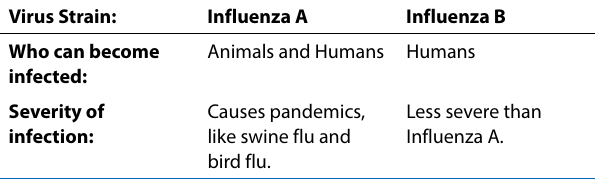
Table 1: Types of influenza strains and their differences 1 .